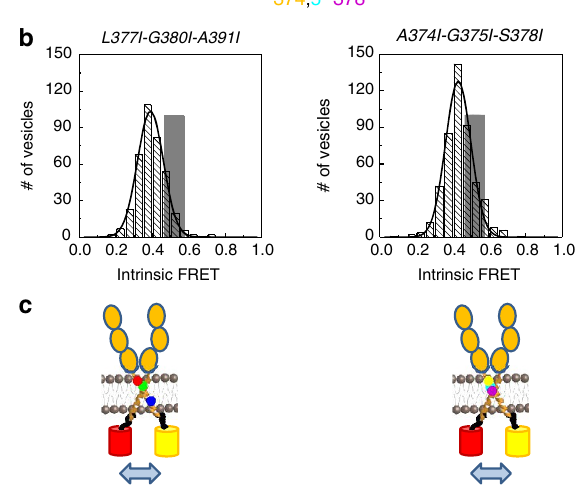
Figure 4 | The L377I-G380I-A391I and the A374I-G375I-S378I sets of mutations affect the unliganded dimer state. ( a ) Sequence of FGFR3 TM domain, with the mutations that were engineered in this study underlined. The L377I-G380I-A391I set of mutations (left) were engineered to destabilize the interface in the FGFR3 dimer structure, solved for the isolated TM domain in detergent micelles 46 . The A374I-G375I-S378I mutations (right) were engineered to destabilize a putative alternative dimer structure, mediated by GxxxG-like motifs 46 . ( b ) Intrinsic FRETvalues measured for the L377I-G380I-A391I (left) and A374I-G375I-S378I (right) mutants in the absence of ligand. Dark grey Gaussians: histograms of single-vesicle intrinsic FRET measured for the constitutively dimeric EC þ TM L377I-G380I-A391I (left) and A374I-G375I-S378I (right) mutants in the absence of ligand (Supplementary Figs 8 and 9). Grey bars: intrinsic FRET for the wild-type EC þ TM, obtained by fitting the FRET data to a dimerization model (Table 1). The width of the bar represents the standard error from the fit. The intrinsic FRET decreases due to both mutations, suggesting that the fluorescent proteins in the mutant dimers move away from each other due to the mutations. ( c ) Graphic representation of the effect of the mutations on structure, indicating an increase in separation between the fluorescent proteins. Cartoons are not drawn to